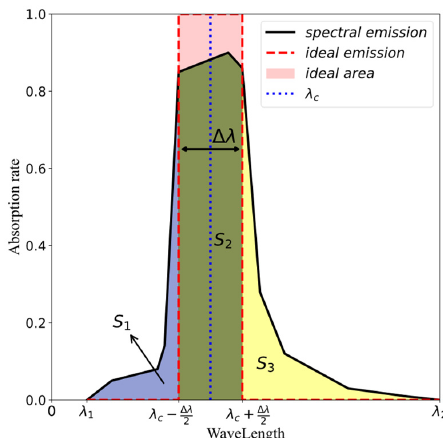
Figure 1. Mathematical interpretation of PEF. S 2 represents the effective area in the target band. S 1 and S 3 represent the areas out of the target band, to the left and right of S 2 respectively.